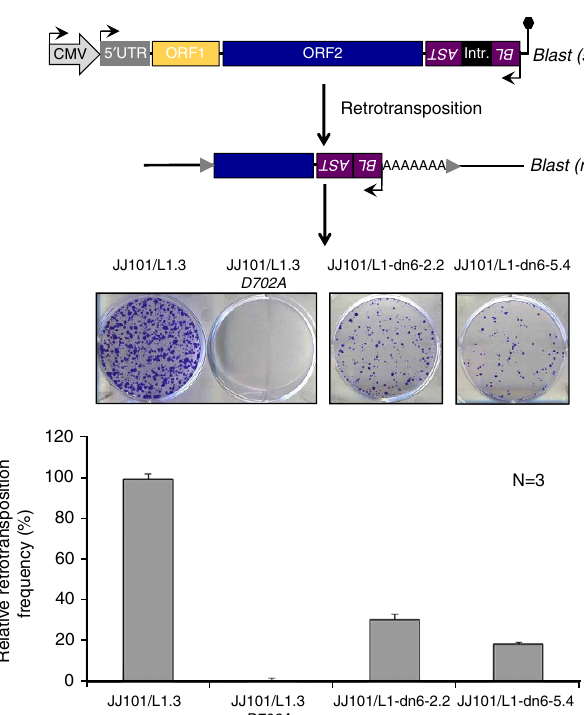
Figure 4 | De novo full-length L1 insertions retain retrotransposition competency in vitro. Intact, full-length L1 insertions L1-dn6-2.2 and L1-dn6- 5.4 were obtained from two independent genomic PCR reactions amplifying the L1-dn6 de novo insertion, tagged with an mblastI retrotransposition indicator cassette, and inserted into an episomal expression plasmid where they were transcriptionally controlled by the CMV promoter. Resulting L1